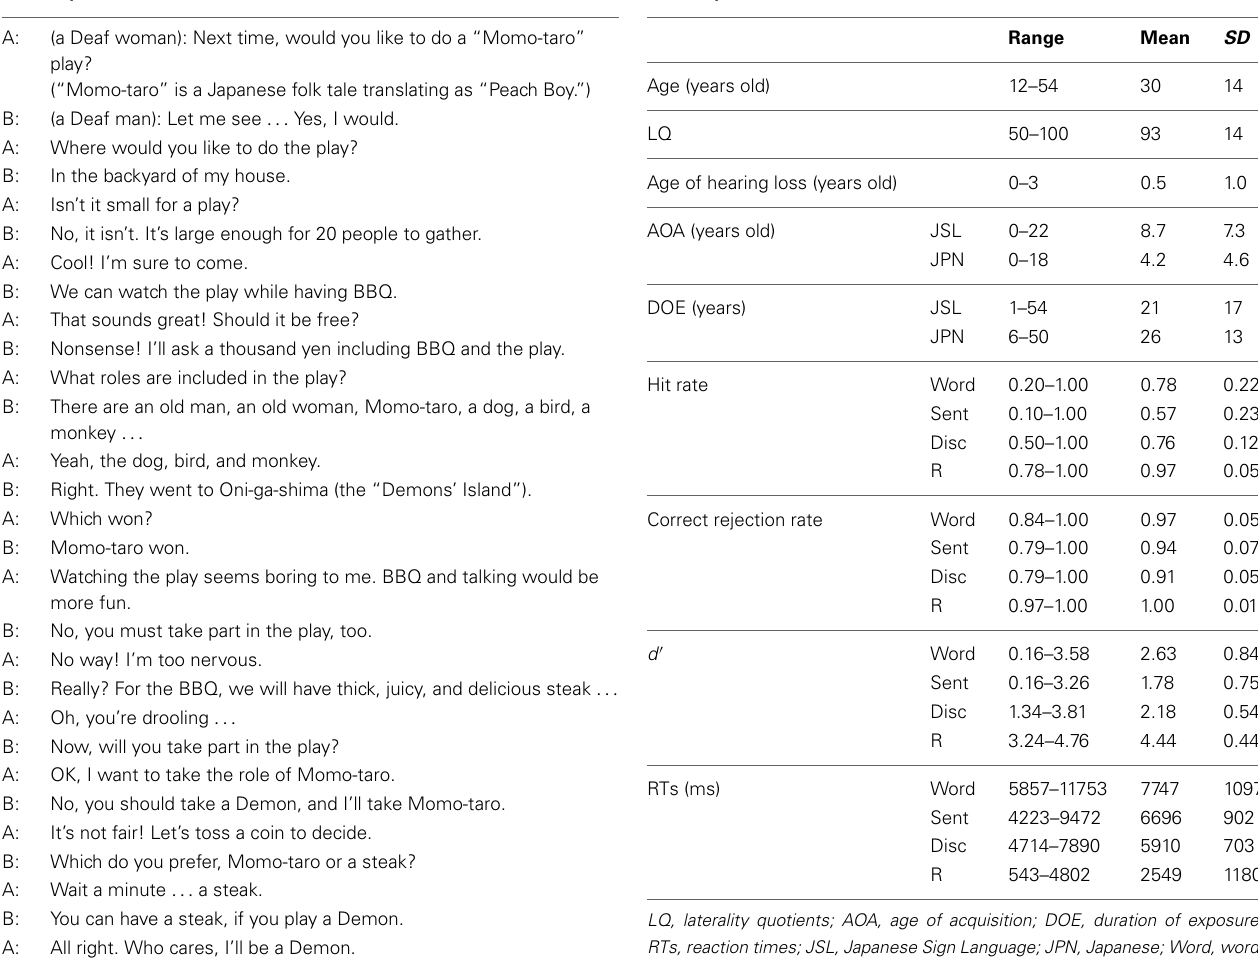
Table 1 | English translation of JSL discourse sentences. Table 2 | Participants’ profiles and behavioral data for the